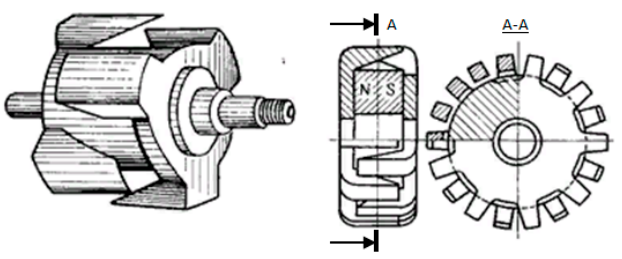
Figure 1. The rotor form of the Claw-Pole Synchronous Machine with permanent magnet.